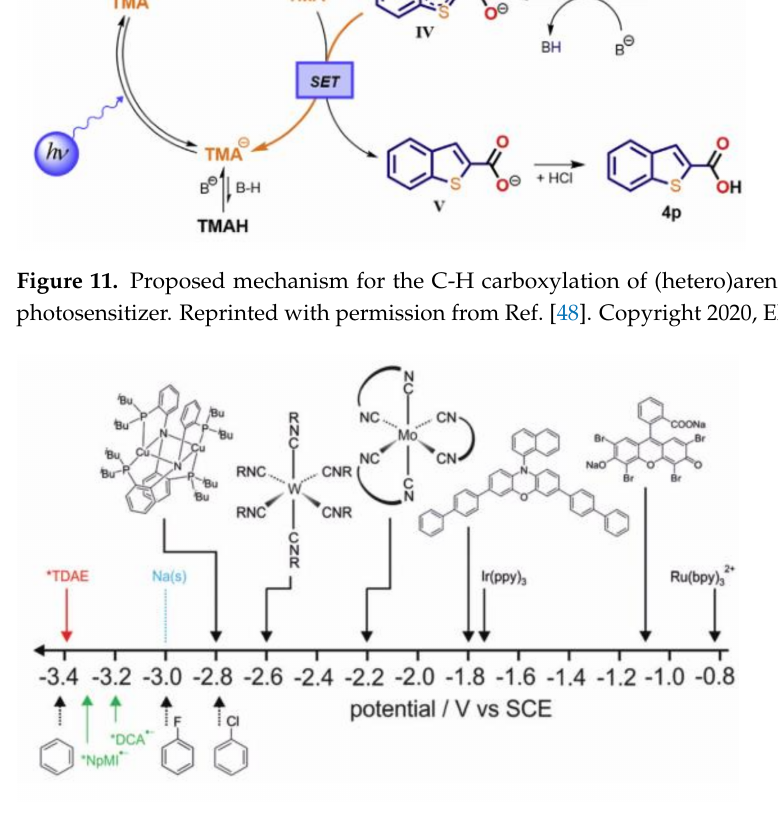
Figure 12. Overview of some of the most potent excited-state photoreductants operating on the basis of single excitation with visible photons known to date. Reprinted with permission from Ref.